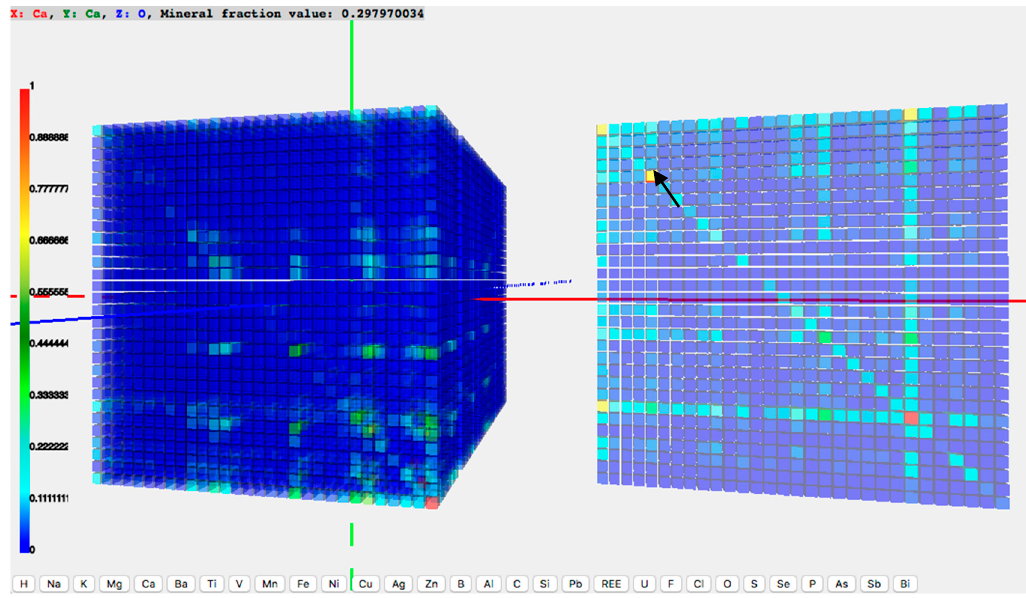
Figure 3. Use a ‘mouse over’ operation to see attributes of a matrix cell. The cell below the cursor is highlighted, and the attributes of the cell is shown on the top of the window. The value ‘0.297970034’ means that about 29.8% of minerals containing oxygen also contain calcium.